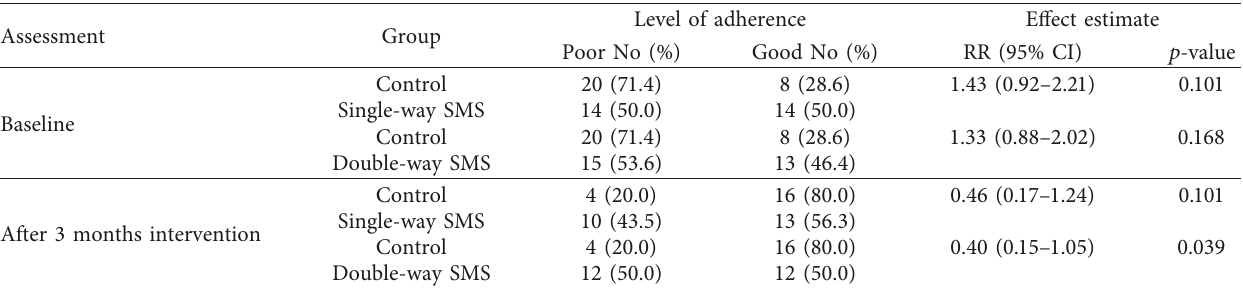
Table 8: Adherence to TB treatment between the single-way and double-way SMS and control of the groups before and after 3 months of intervention.